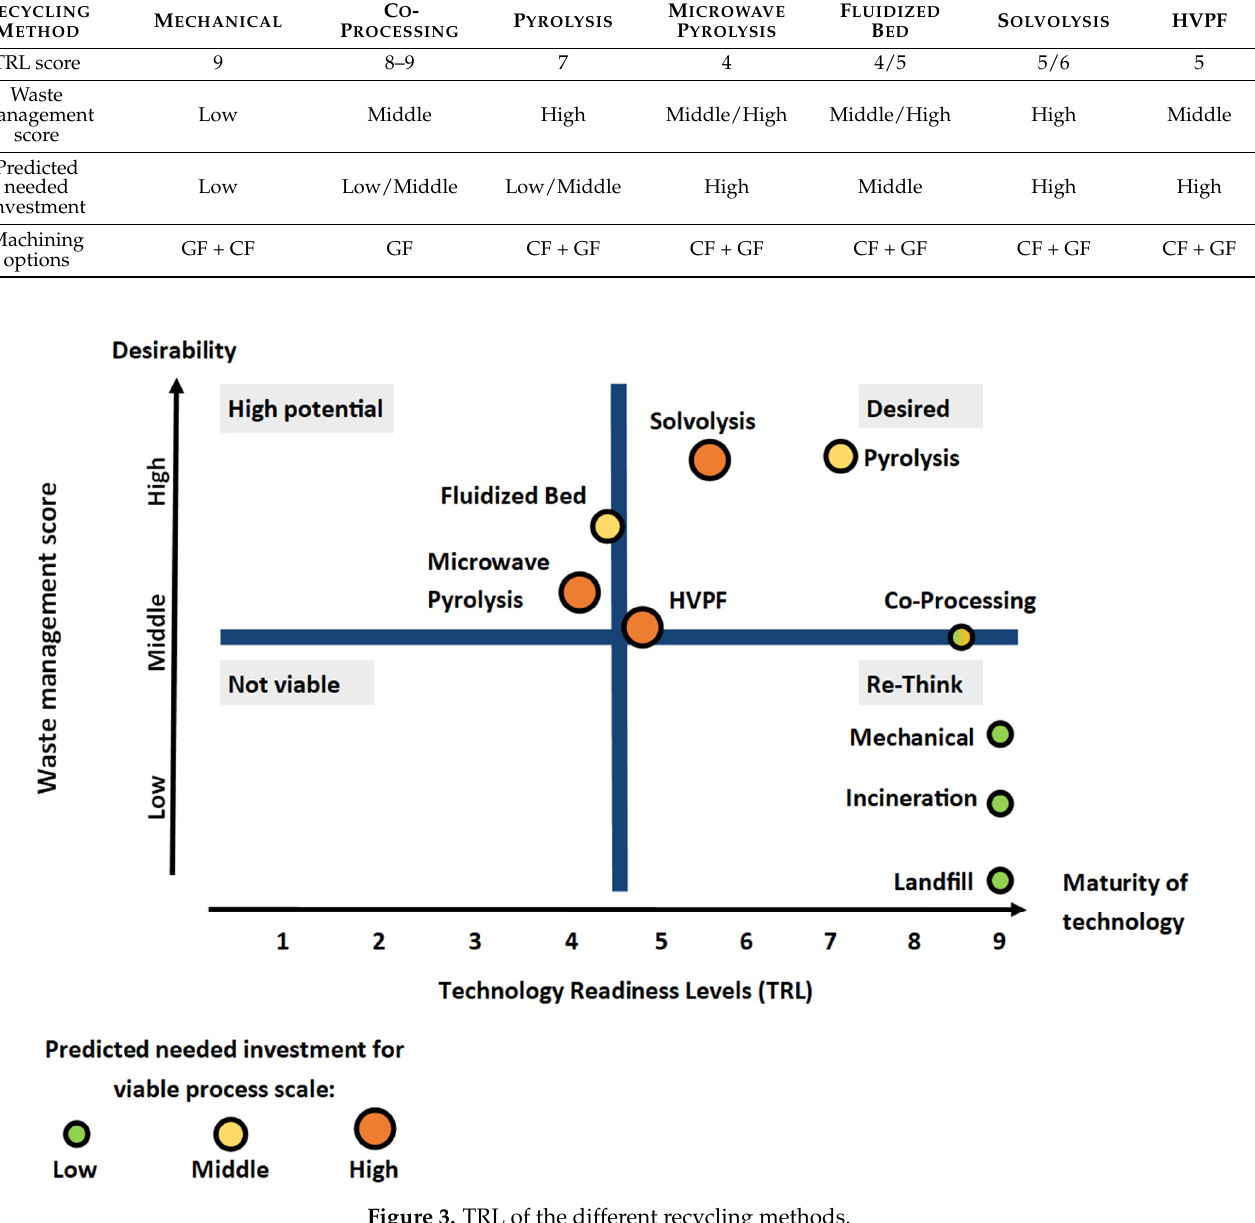
Figure 3. TRL of the different recycling methods.